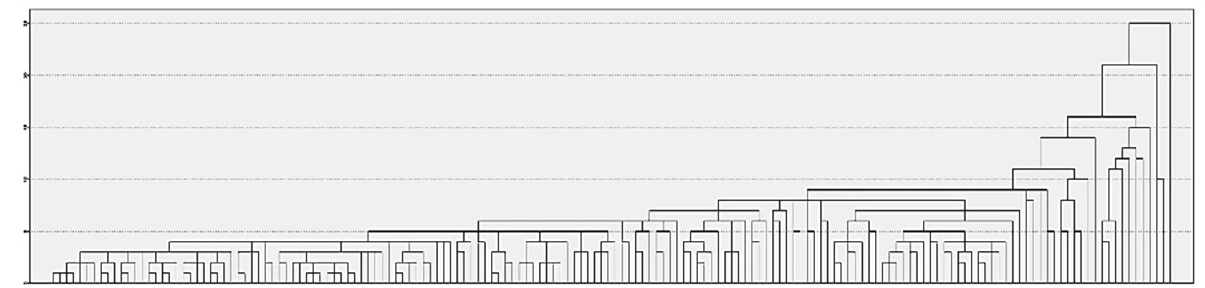
Figure 8. Tree diagram (differences between the group clusters).